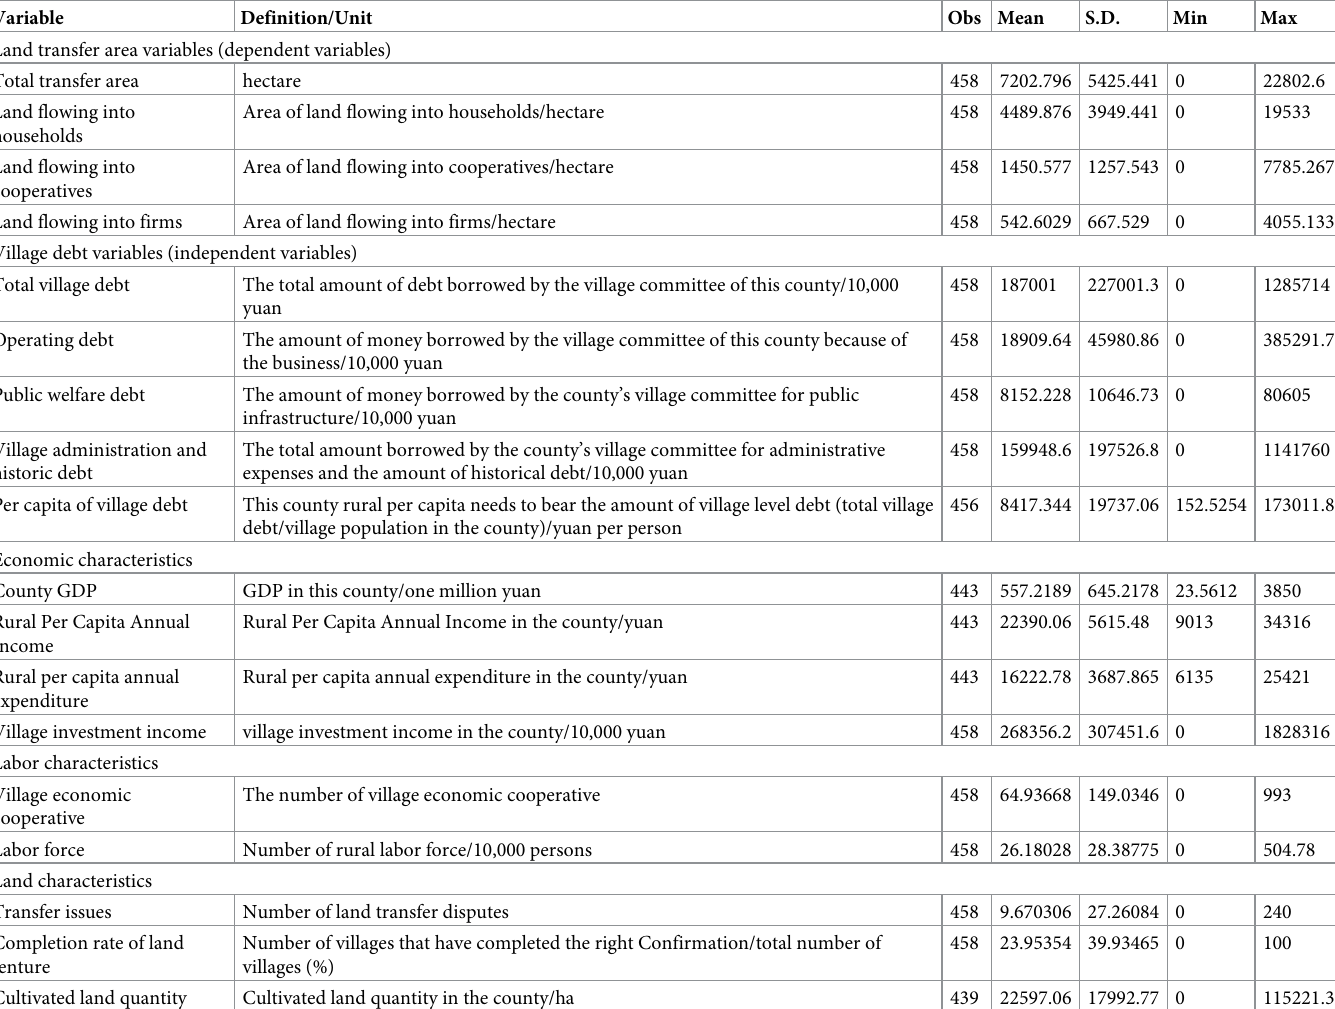
Table 1. Definitions and descriptive statistics of